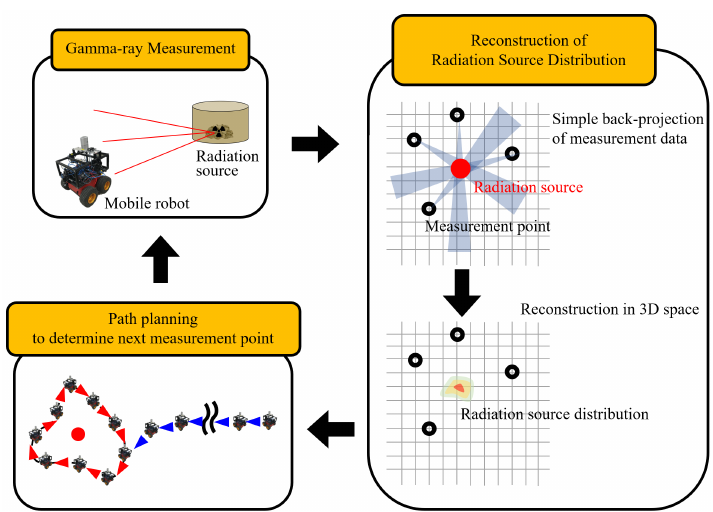
Figure 2. Schematic of proposed method: the proposed method consists of three parts: gamma-ray measurement, reconstruction of the radiation source distribution, and path planning. The robot repeats the gamma-ray measurement, reconstruction, path planning, and movement until the path is